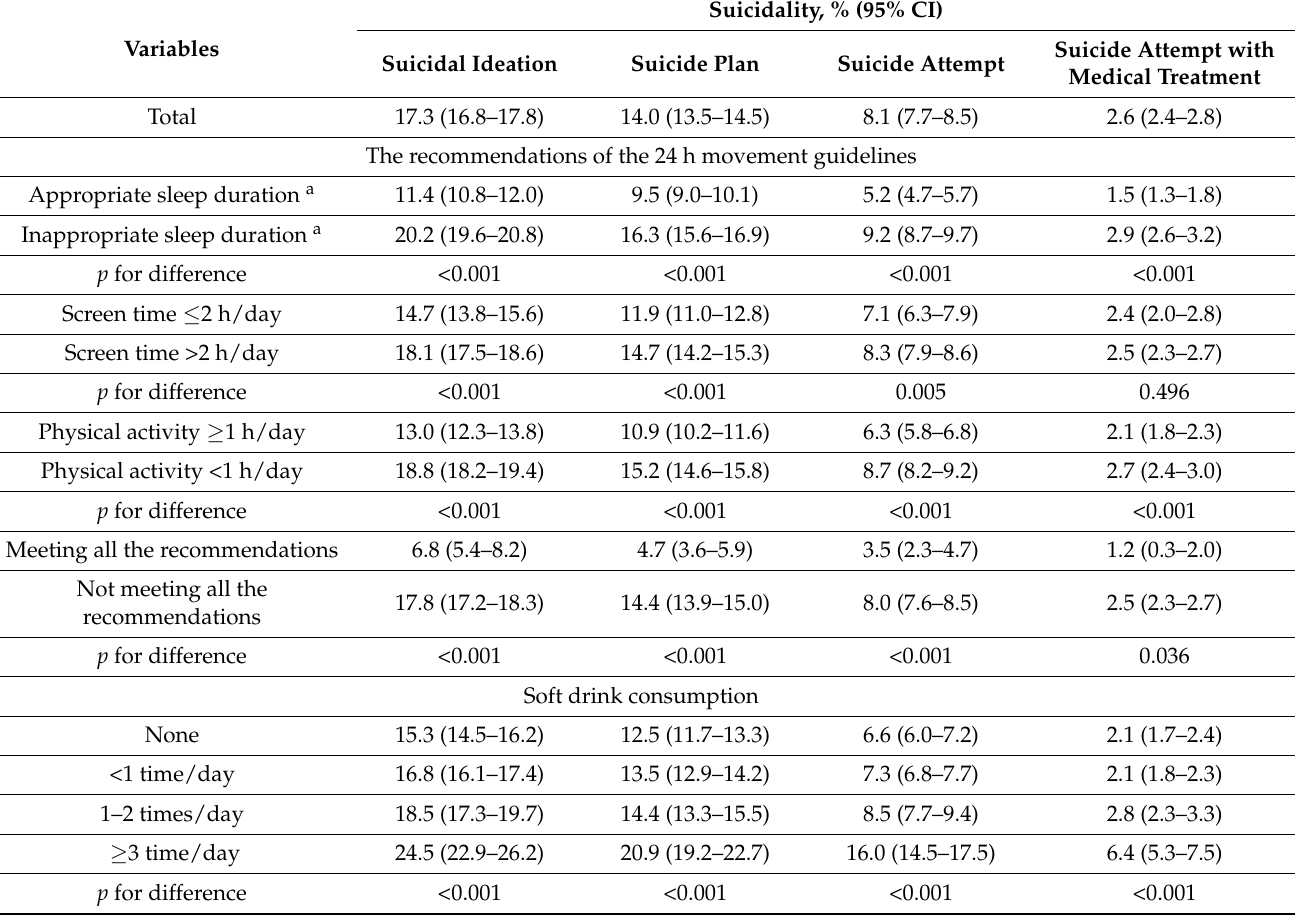
Table 1. The weighted prevalence of meeting the recommendations of the 24 h movement guidelines and suicidality by levels of soft drink consumption among adolescents of the